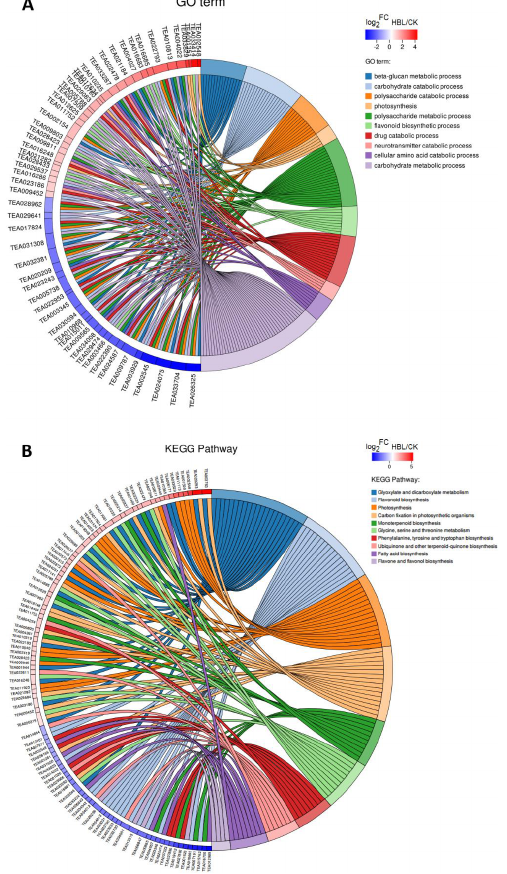
Figure 4. Chord plot of the top 10 Gene Ontology (GO) terms ( A ) and Kyoto Encyclopedia of Genes and Genomes (KEGG) pathways ( B ). Chords show a detailed relationship between the log 2 -fold change (log 2 FC) of DEGs (left semicircle) and their enriched GO terms or KEGG pathways (right